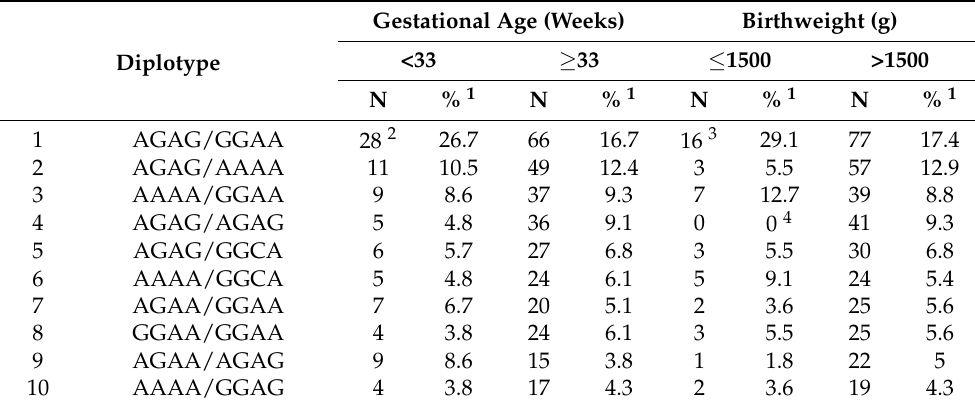
Table 6. Frequencies of the most common diplotypes in preterm newborns, depending on gestational age and